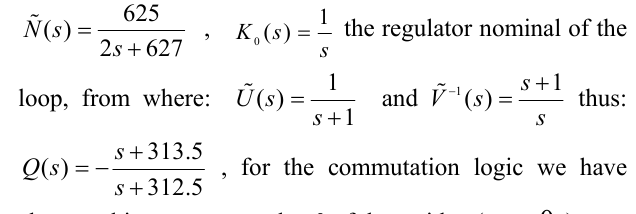
(t) and V (t) in permanent mode 2 3